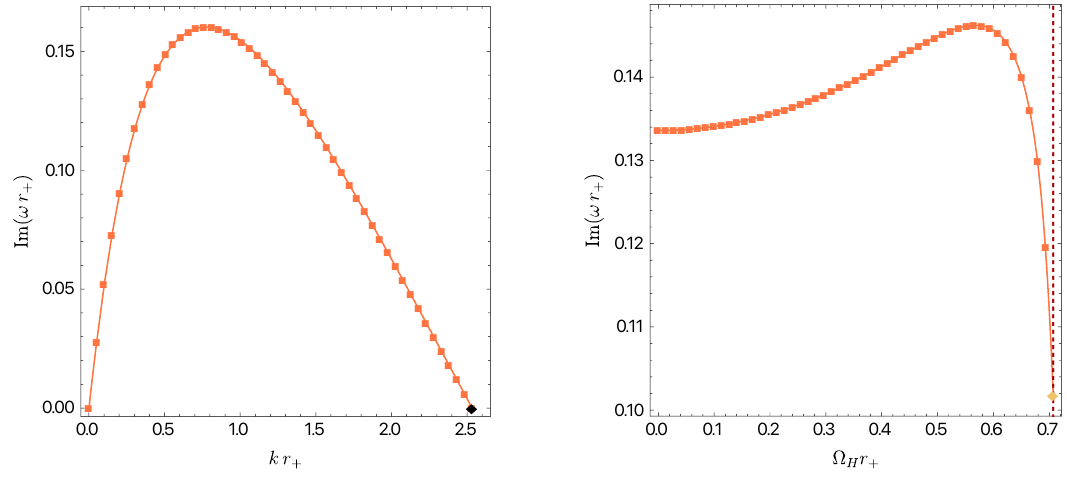
Figure 2 . Growth rate for the Gregory-Laflamme instability of the Myers-Perry black string with fixed e Ω H = 0 . 66 (left), and with e k = 1 (right). Note that in the right plot, e k GL e k GL (0) 2 with e Ω H according to figure 1, so e k varies as well. The yellow diamond in the right panel at √ ( e Ω H , ω ) ' (1 / 2 , 0 . 101756) is the extrapolated value of the growth rate at extremality (vertical e dashed